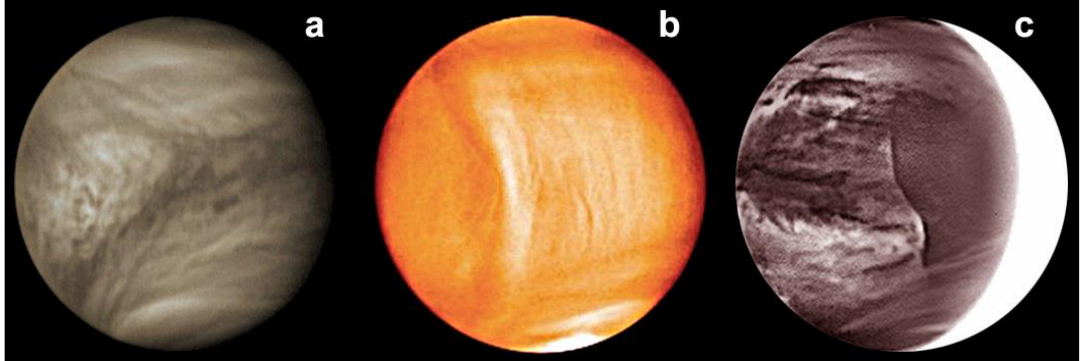
Figure 1. Examples of planetary waves on the clouds of Venus during 2016. These images taken with different cameras onboard JAXA’s Akatsuki mission exhibits: ( a ) the Y-feature observed on the albedo of the top of the upper clouds in a 365 nm image taken by Akatsuki/UVI, ( b ) the stationary wave over Aphrodite Terra apparent on the brightness temperature of the upper clouds in a 10-µm image from Akatsuki/LIR, and ( c ) the discontinuity or “disruption” apparent on the opacity of the nightside lower clouds in a 2.26-µm image acquired with Akatsuki/IR2.